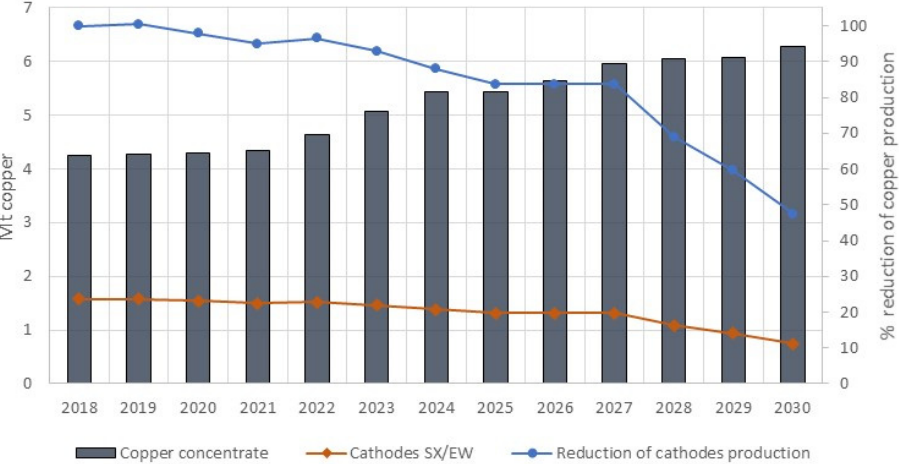
Figure 1. Projected production of copper concentrates (excluding smelting and refining), Cathodes by solvent extraction/electrowinning (SX/EW) and reduction of cathodes production in Chile 2019–2030 by COCHILCO [2].